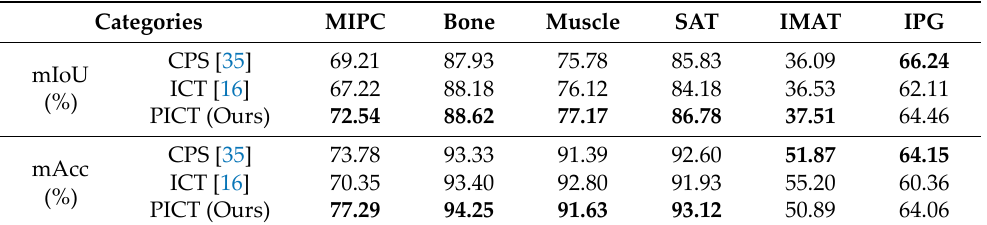
comparing variants.